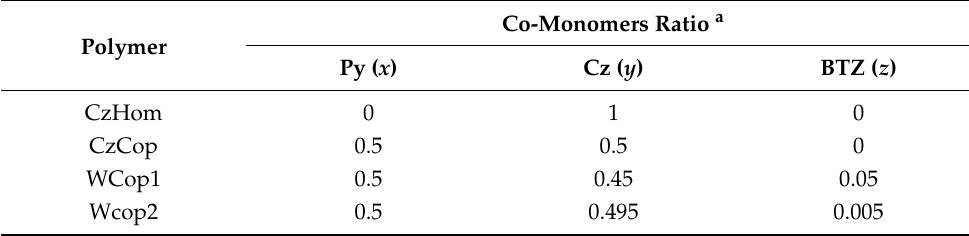
Table 1. Molar ratios of Copolymers that were synthesized in this work.